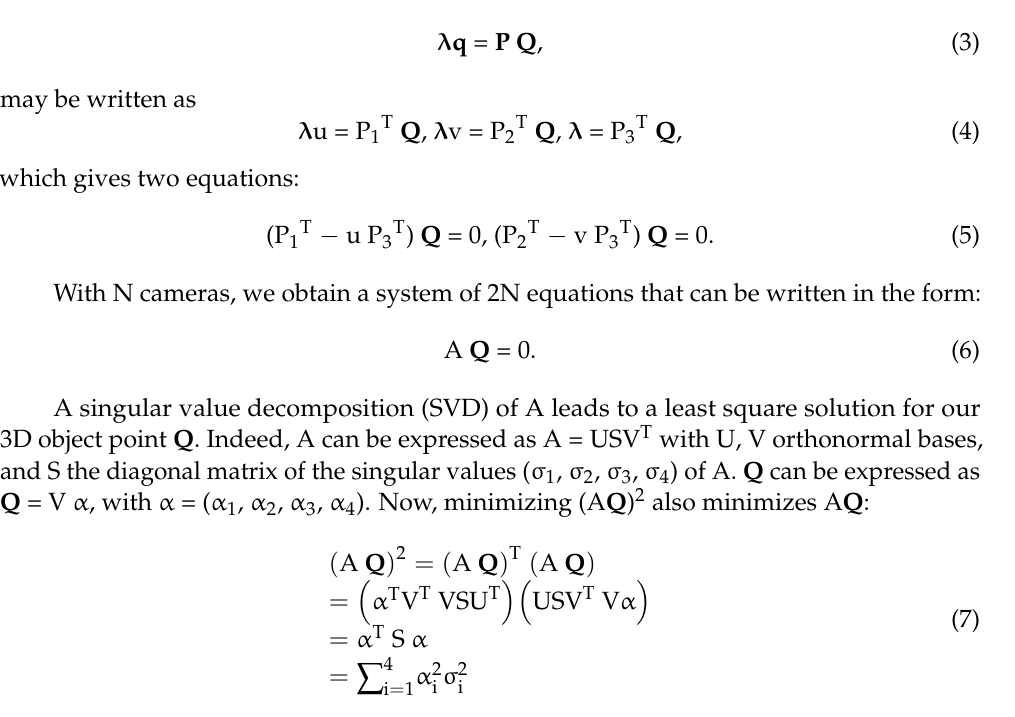
Algorithm 1. Proof of the classic direct linear transformation (DLT), commonly used to solve the triangulation of 2D coordinates from several cameras with a least square approach